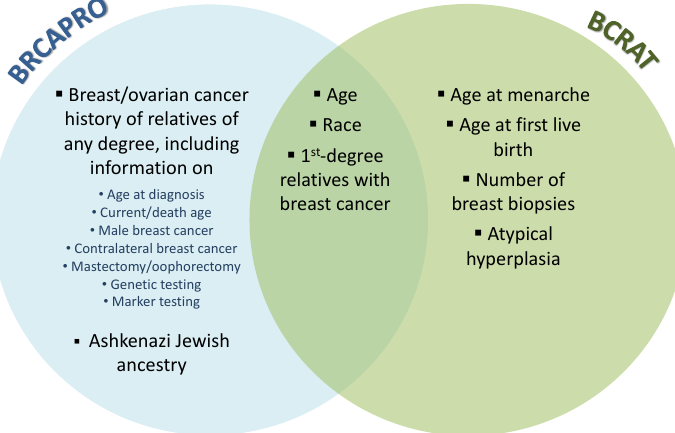
Figure 1. Inputs to BRCAPRO and BCRAT and their